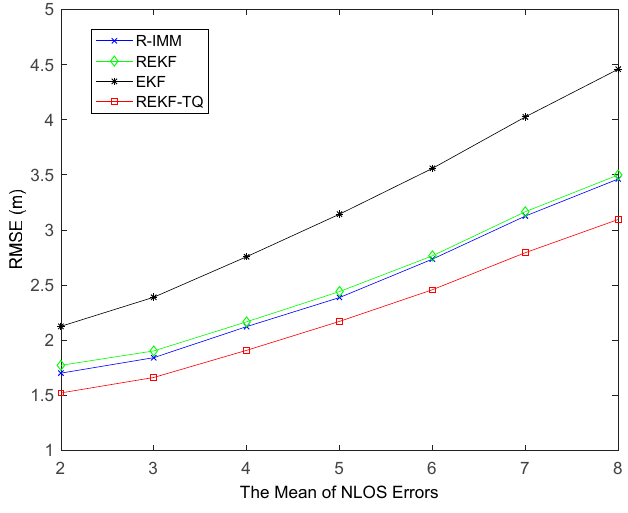
Figure 6. The RMSE versus mean of NLOS errors.